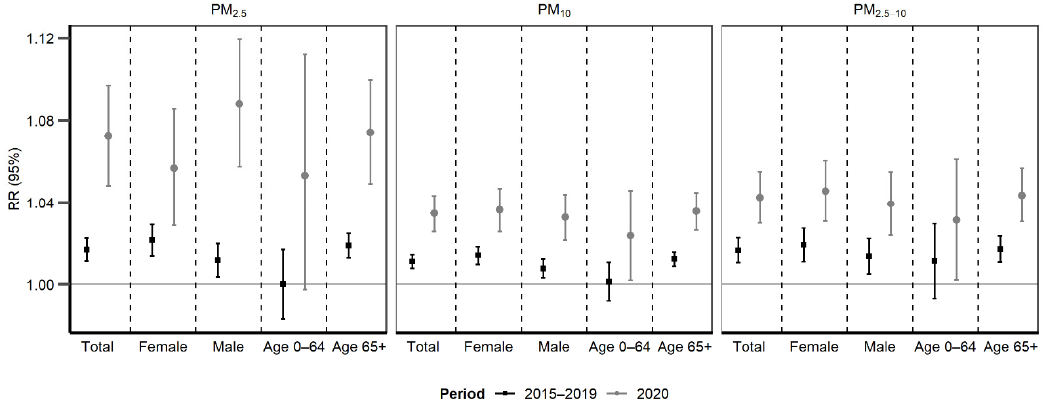
Figure 2. Cumulated relative risk (RR) of all-cause mortality and group-specific mortality associated with a 10 µ g/m 3 increase in the concentrations of particulate matter (PM 2.5 with an aerodynamic diameter ≤ 2.5 µ m; PM 10 , ≤ 10 µ m; PM 2.5–10 , 2.5–10 µ m). Table 2. Attributable fractions and attributable counts of all-cause mortality due to PM 2.5 , PM 10 , and PM 2.5–10 during March to May in 2020 and 2015–2019,